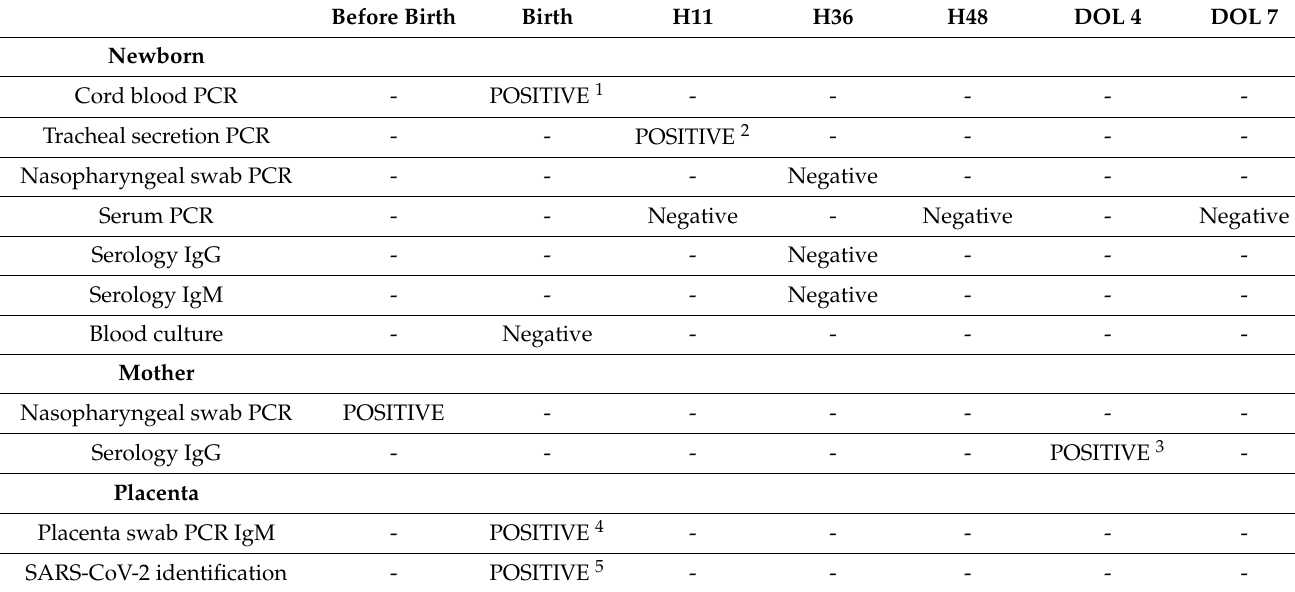
Table 1. Case 1: neonatal, maternal, and placental